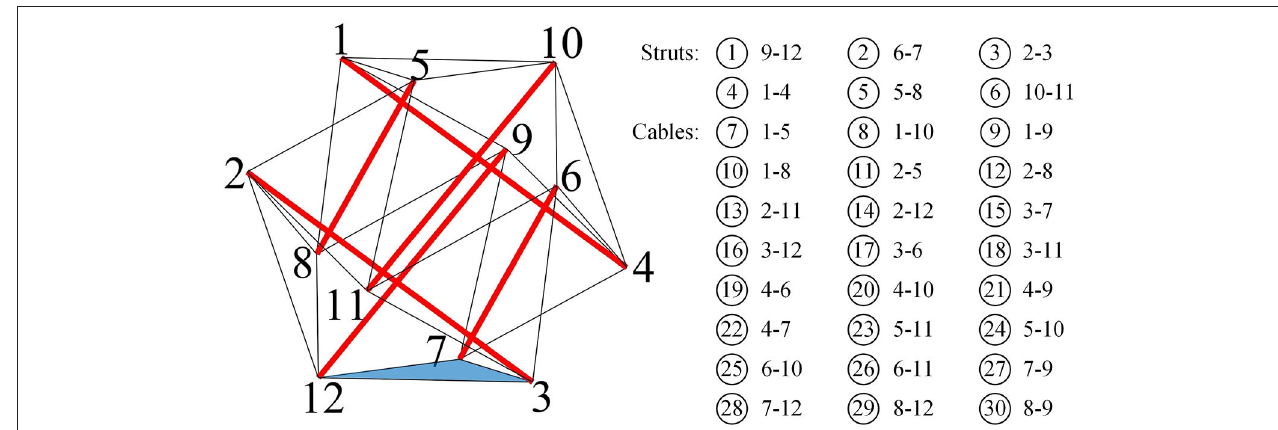
FIGURE 6 | Six-strut tensegrity system.